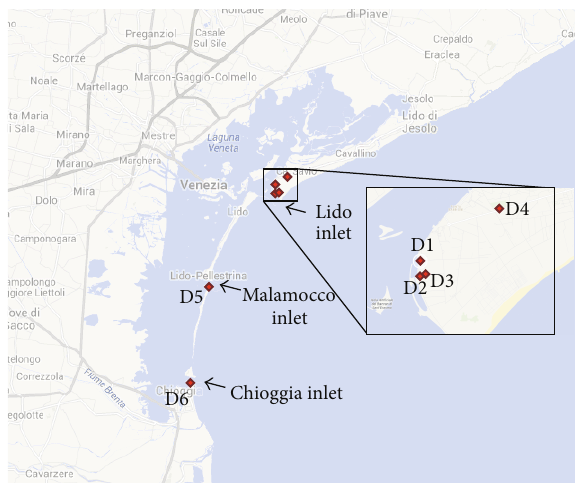
Figure 1: Maps of the sites of the